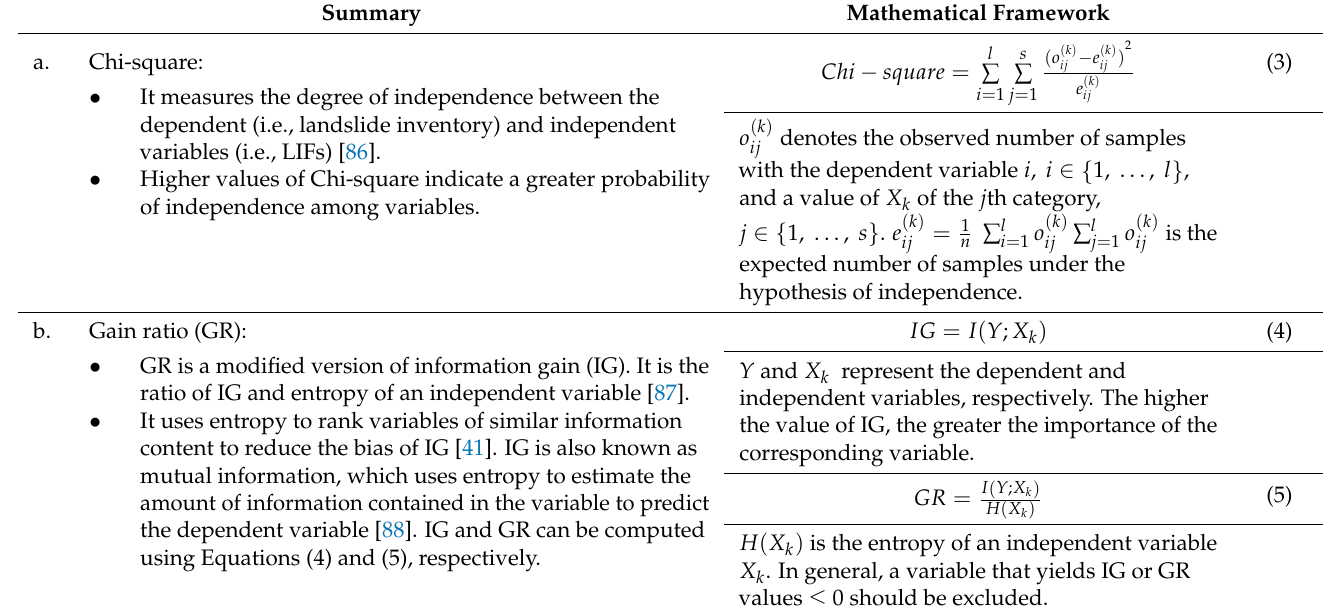
Table 2. Summary and mathematical framework of implemented FS